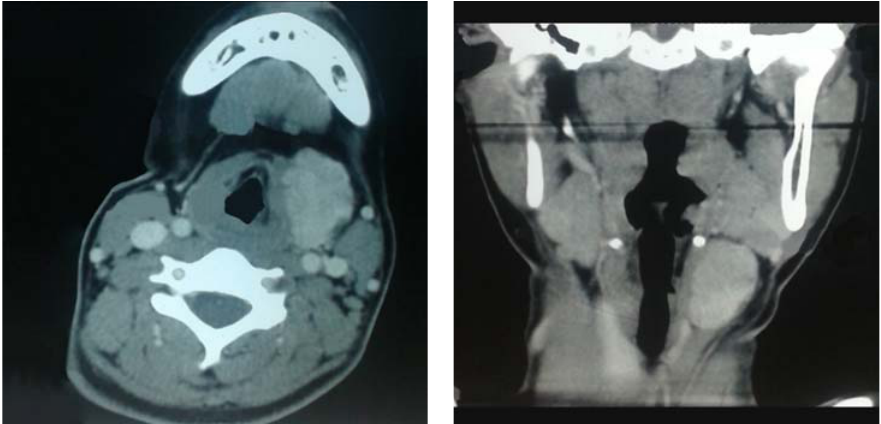
Figure 2: CT scan showing the soft tissue mass in the neck (axial and coronal view).